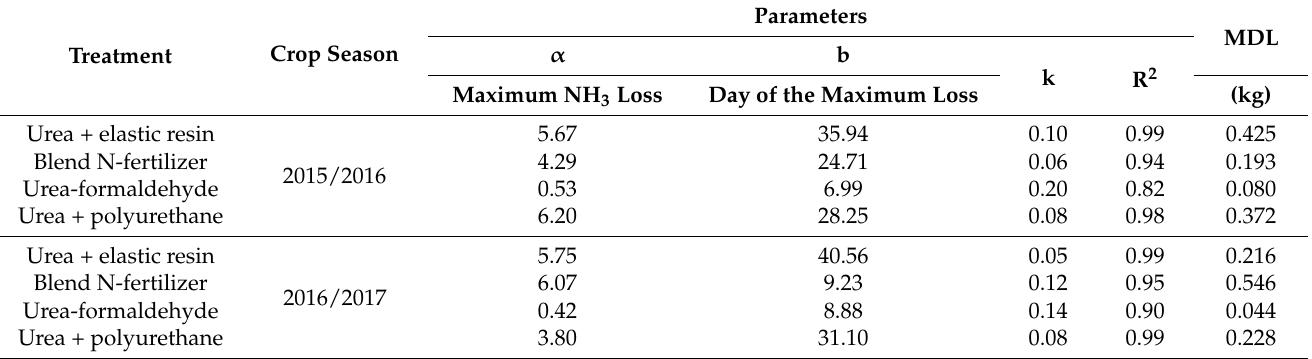
Table 4. Regression parameters adjusted for the accumulated and maximum daily losses of N-NH 3 from slow-release and controlled-release N fertilizers in the 2015/2016 and 2016/2017 crop seasons.